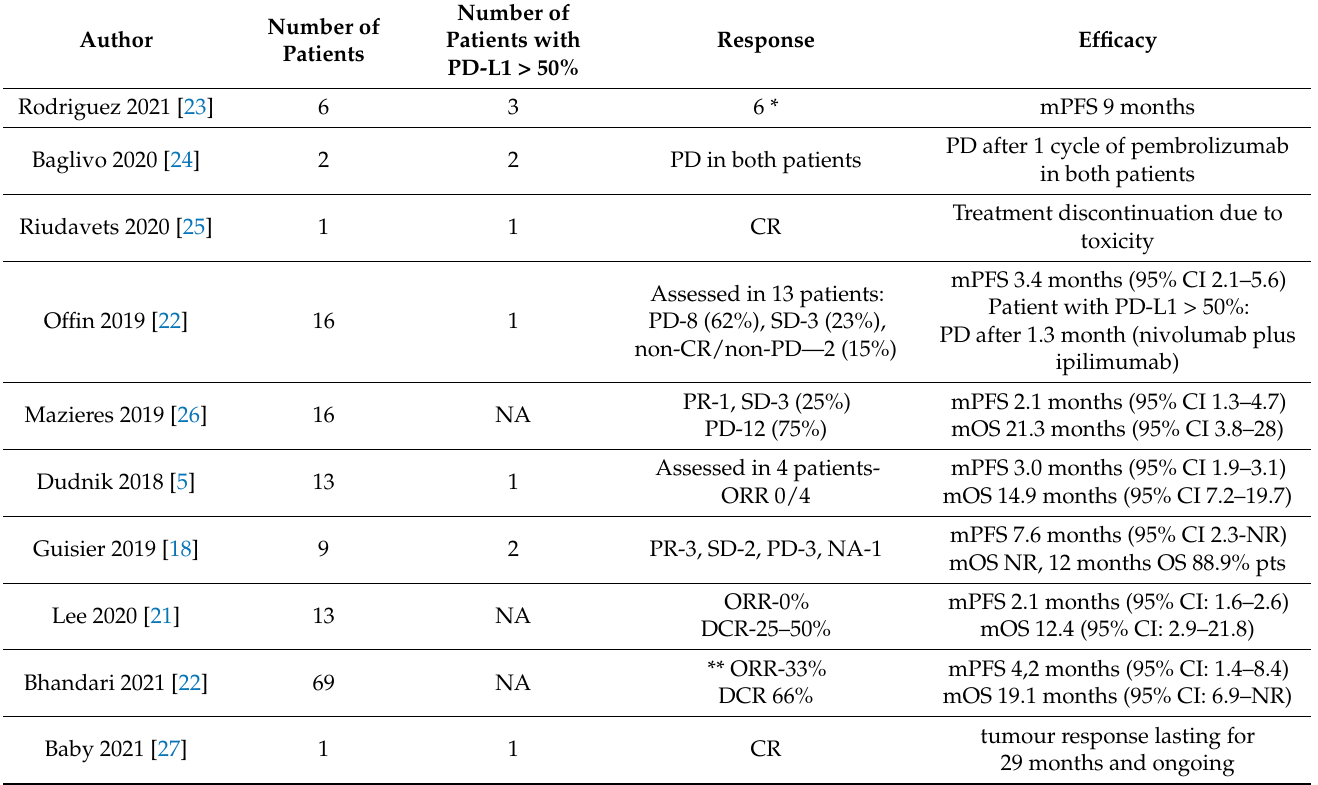
Table 1. Clinical outcomes with immune-checkpoint inhibitors monotherapy in RET -rearranged lung cancer